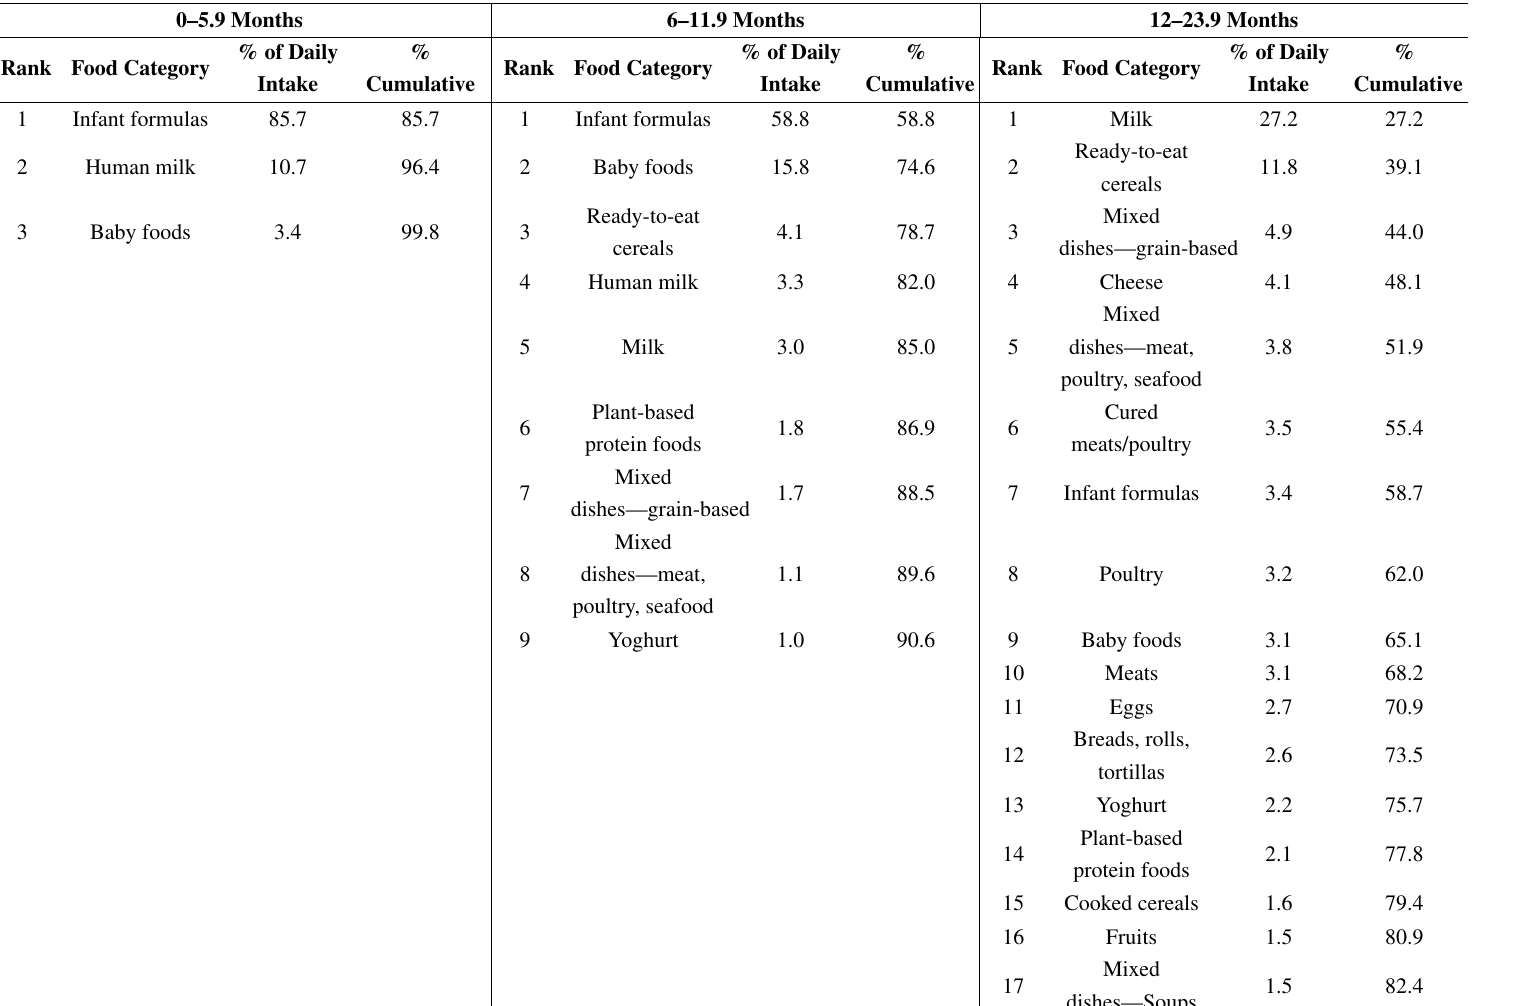
Table 18. Food sources of zinc among US infants and toddlers aged 0–23.9 months by age group: NHANES 2005–2012 ( n = 2740) a